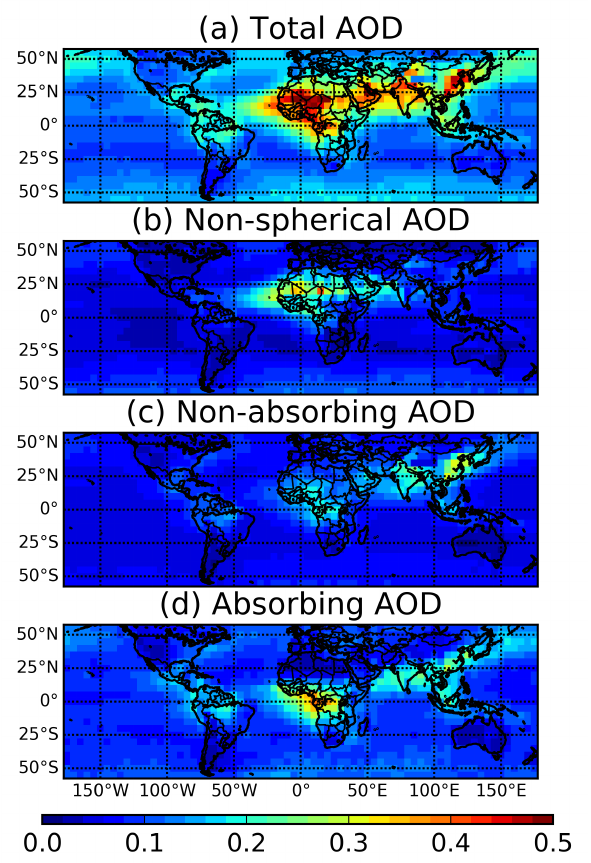
Figure 1. The 17-year mean optical depths of ( a ) total aerosols, ( b ) non-spherical aerosols, ( c ) non- absorbing aerosols, and ( d ) absorbing aerosols from the MISR JOINT_AS